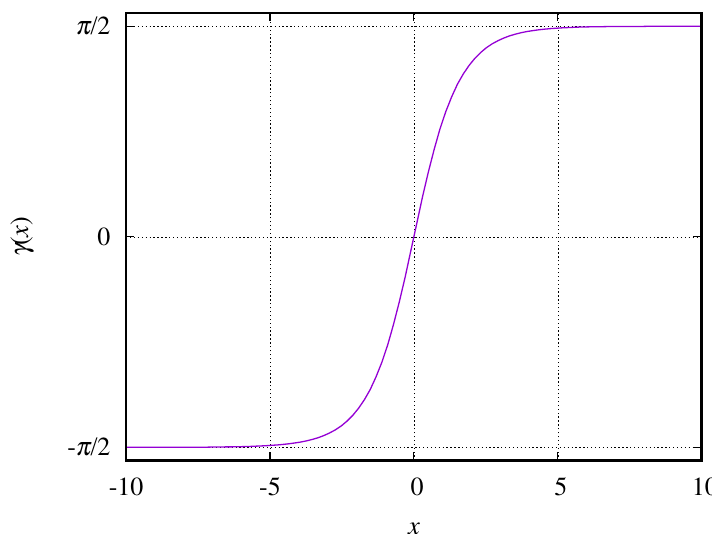
Figure 5 . Transition between vacuum II with (cid:13) ( z ) = (cid:0) (cid:25)= 2 and vacuum I with (cid:13) ( z ) = (cid:25)= 2 using the substitution x = M (cid:25)